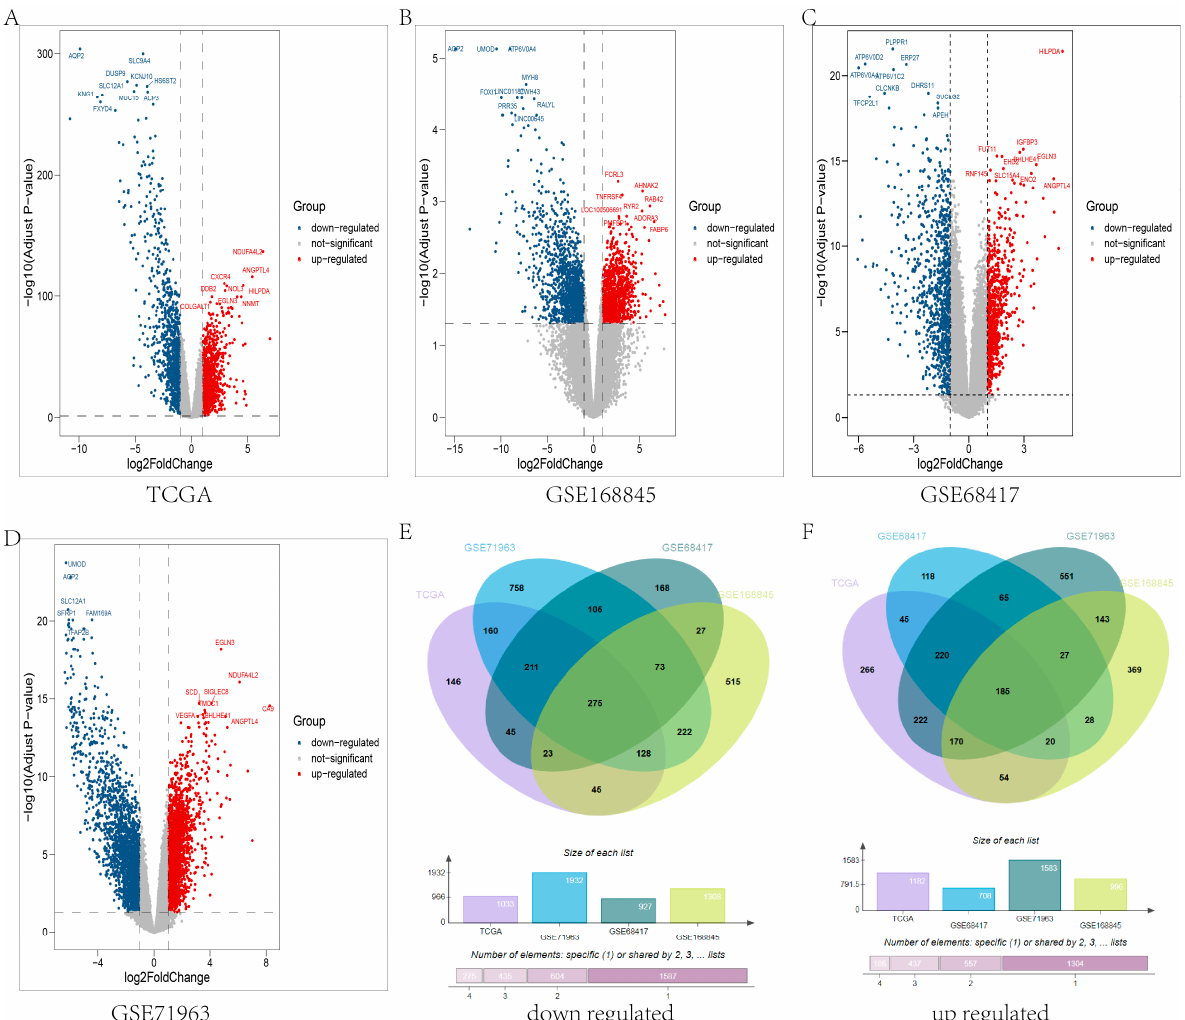
Figure 2. Volcano plots and Venn diagrams visualize the DEGs. ( A – D ) The volcano plots reveal the DEGs between RCC and normal tissues of the TCGA dataset ( A ), GSE168845 ( B ), GSE68417 dataset ( C ), and GSE71963 dataset ( D ) with thresholds set at 2-fold change and p < 0.05. Blue points indicate downregulated genes, and red points represent upregulated genes. ( E ) Venn diagram displaying the intersection of downregulated DEGs. ( F ) Venn diagram displaying the intersection of upregulated DEGs. The bars in E and F mean the size of DEG lists of TCGA, GSE71963, GSE68417, and GSE168845.